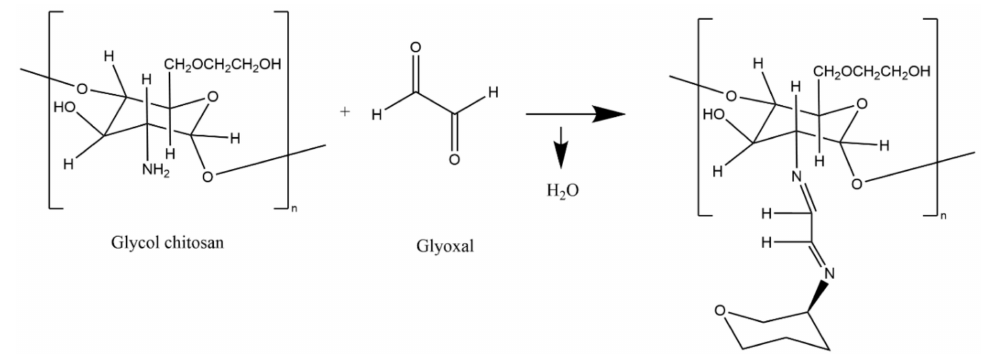
Figure 6. Chemical cross-linking of glycol chitosan using glyoxal [106,119,123]. Kaczmarek-Szczypczy´nska et al. [106] conducted research using a 40 wt%